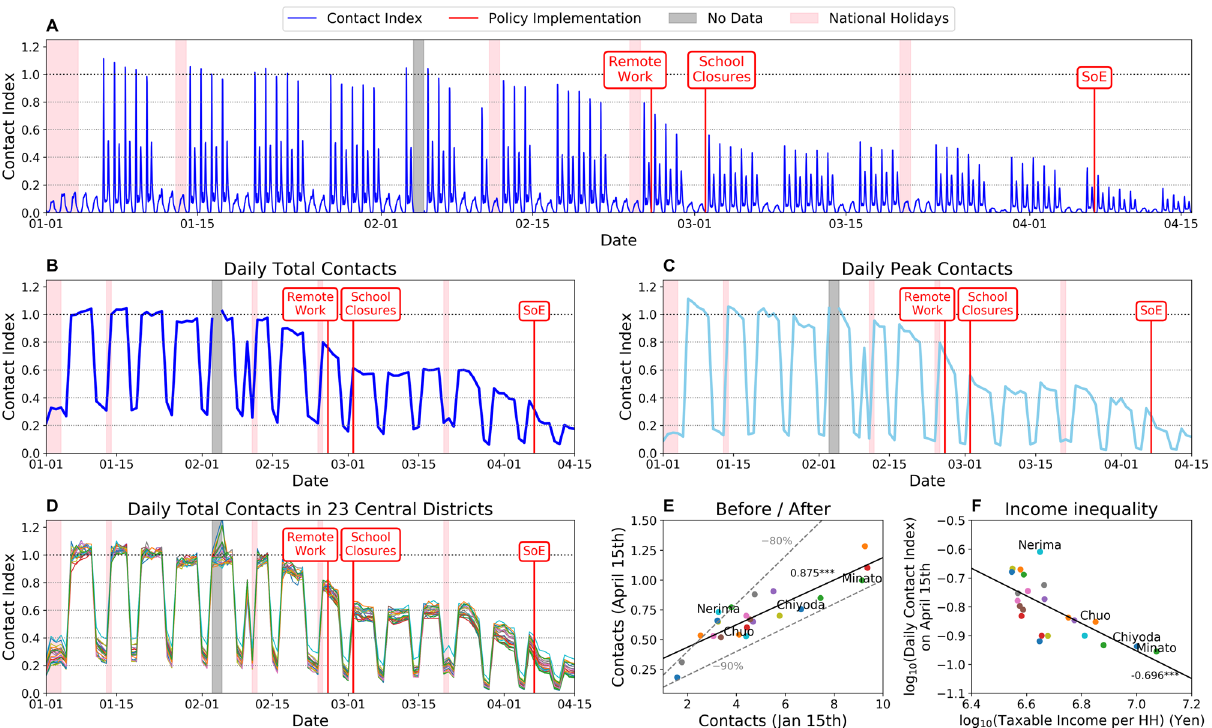
Figure 3. Social contact analysis. ( A ) shows the amount of contacts an individual potentially encounters outside home for each time period. ( B , C ) show the individuals’ mean total daily contacts and the mean daily peak contacts, respectively. ( D ) Daily total contacts in the 23 central districts (wards) in Tokyo Metropolitan Area. ( E ) Correlation between non-normalized social contacts before and after the COVID-19 spread. ( F ) Correlation between average taxable income per household and daily contact index on April